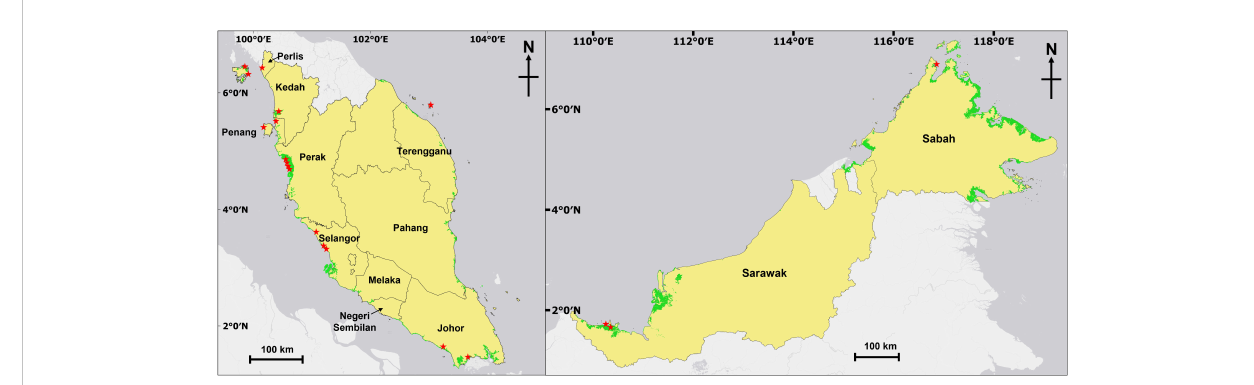
FIGURE 1 Map of Malaysia. Red stars indicate valuation study sites of collated mangrove ecosystem service valuation studies in Malaysia. Green patches overlaying the map indicate mangrove forest coverage (dataset from Bunting et al.,